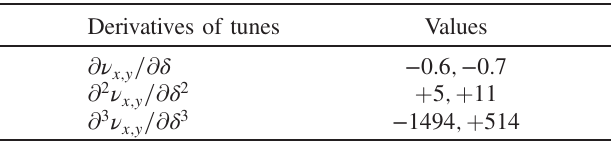
TABLE II. The chromatic tune shifts from the FFS after the